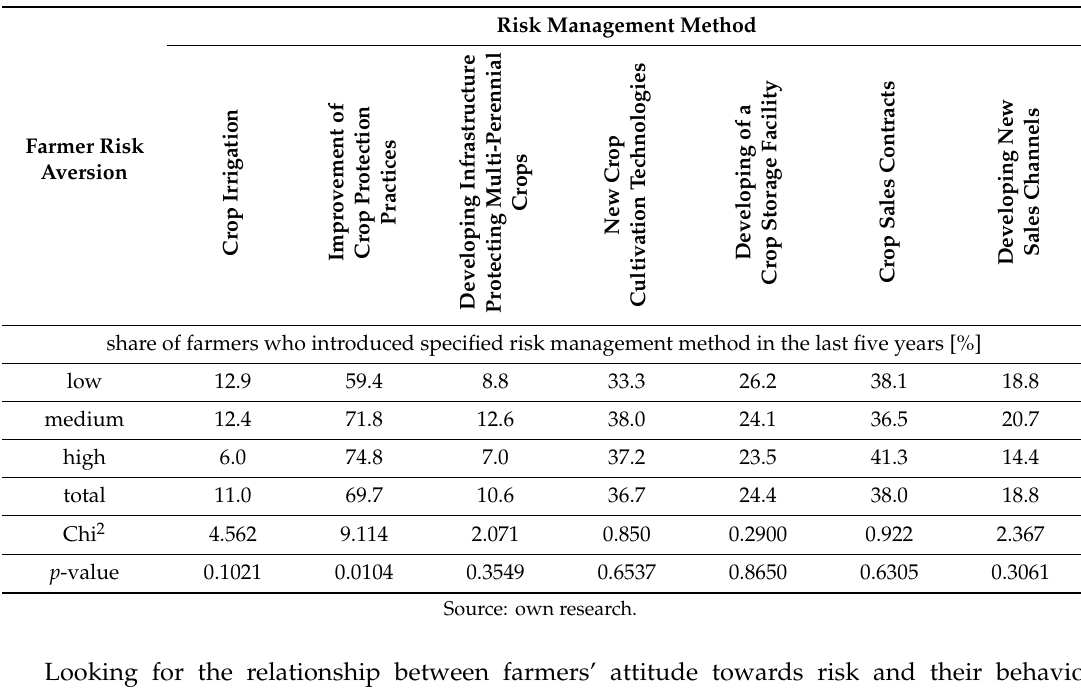
Table 7. The percentage of farmers who implemented the selected risk management methods in the last five years regarding their level of risk aversion.